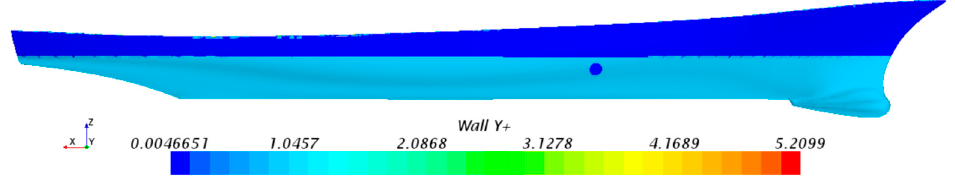
Figure 11. Wall Y + visualization on the hull.